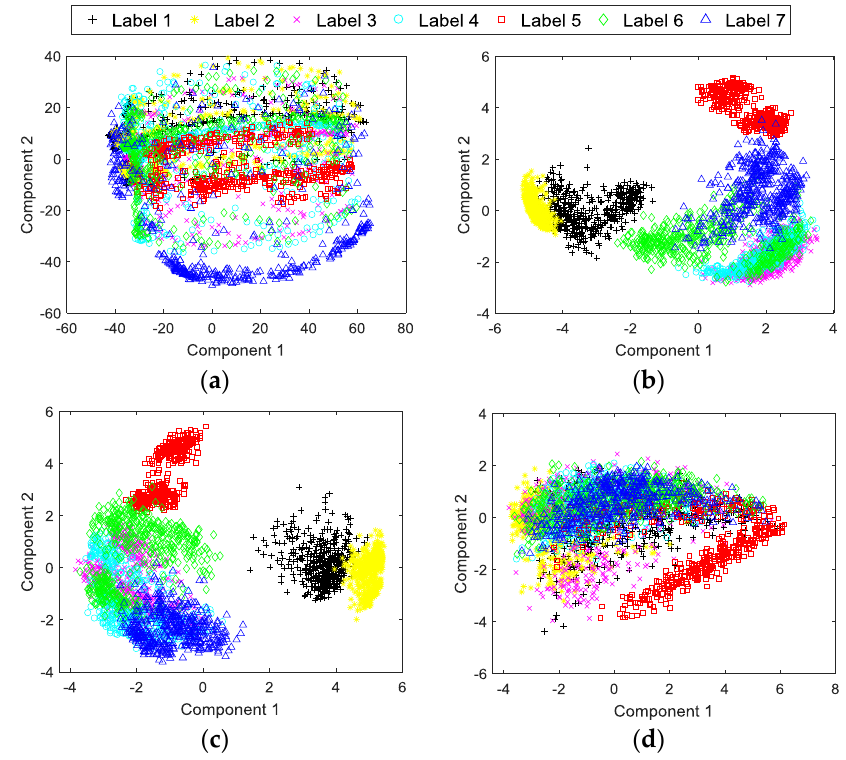
Figure 9. Principal component analysis (PCA) of the experimental data and learned features: ( a ) Data-level fused input data of the proposed method; ( b ) Features of the proposed method; ( c ) Feature-level fused features learned through DCNN; and ( d ) Feature-level fused handcraft features.